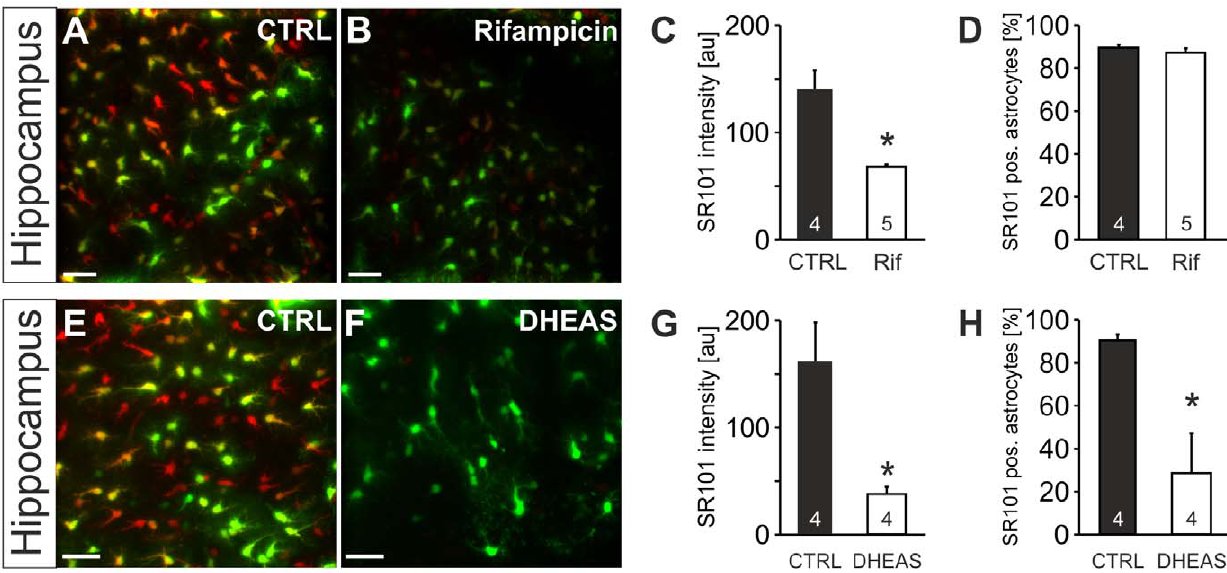
Figure 11. Effects of OATP blockade on SR101-uptake in the hippocampus. A: Overlay of astroglial EGFP-fluorescence (green) and SR101- fluorescence (red) in the hippocampus after a staining in control conditions. B: Rifampicin in the staining solution decreased SR101-fluorescence intensity. C: While the reduction of SR101-labeling by rifampicin (Rif; 100 m M) was significant, the fraction ( D ) of SR101-labeled astrocytes remained unchanged by rifampicin. E: astroglial EGFP-fluorescence (green) and SR101-fluorescence (red) in the hippocampus after a staining in control conditions. F: Reduced SR101-labeling of hippocampal astrocytes when the neurosteroid dehydroepiandrosterone sulfate (DHEAS, 100 m M) was present during SR101-staining. G: The statistical comparison reveals a significant reduction of SR101-fluorescence intensity by DHEAS G: Additionally, the percentage of EGFP-positive astrocytes that were also labeled with SR101 was significantly lowered as compared to control. Scale bars: 40 m m.